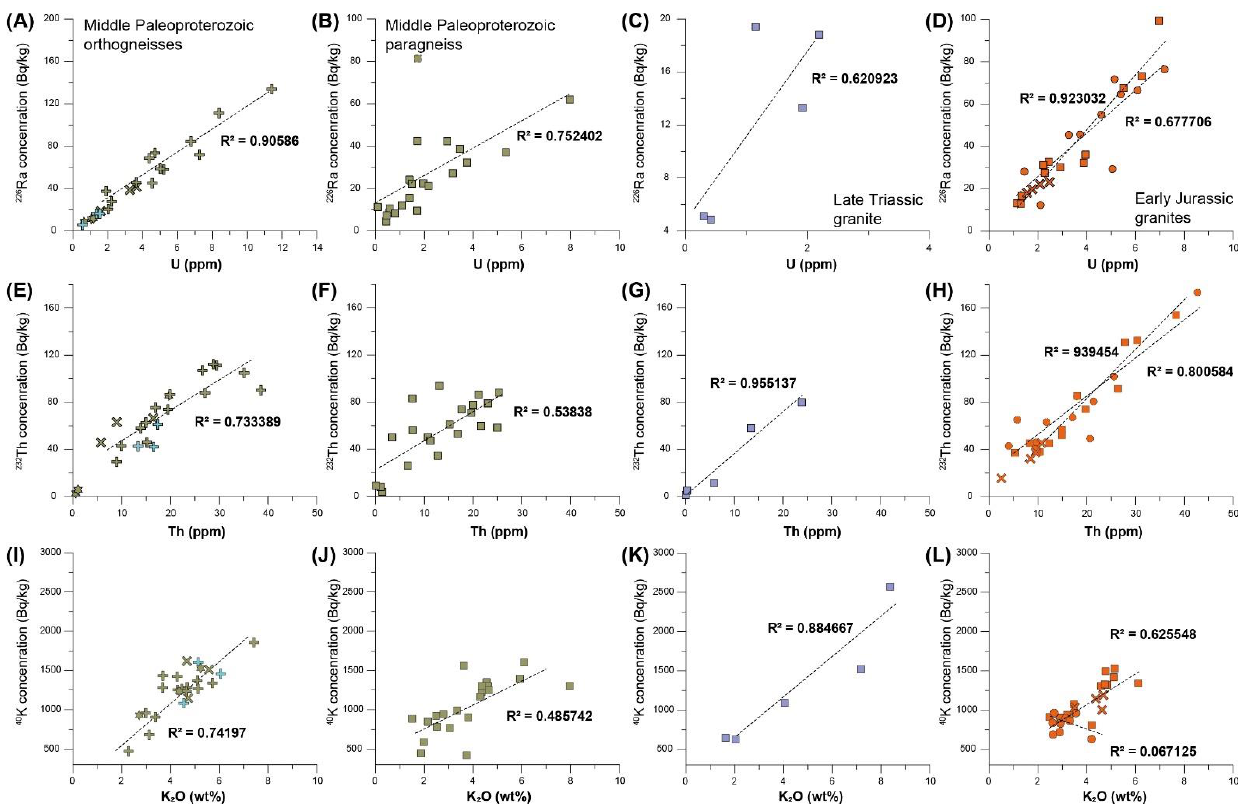
Figure 13. 226 Ra versus U, 232 Th versus Th, and 40 K versus KO 2 diagrams for the Middle Paleoproterozoic orthogneisses ( A,E,I ), Middle Paleoproterozoic paragneisses ( B,F,J ), Late Triassic granite ( C,G,K ), and Early Jurassic granites ( D,H,L ) in the Jangsu-gun area. R 2 is value using linear regression for the number of analyzed samples in each rock unit. Symbols are as in Figures 6 and 7.